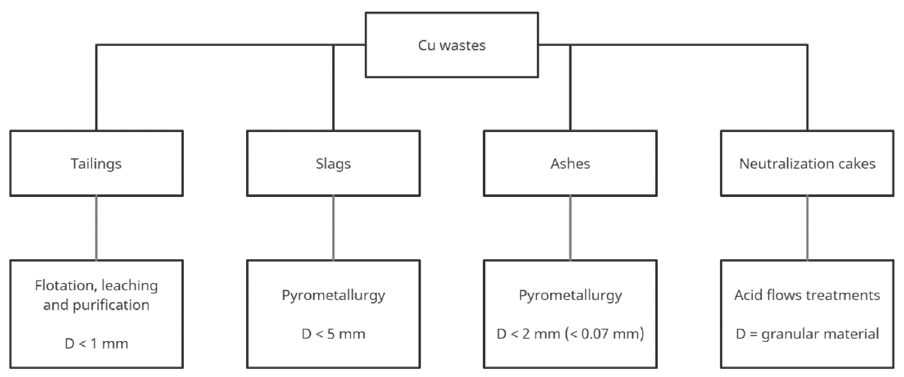
Figure 1. General classification of copper mining waste.